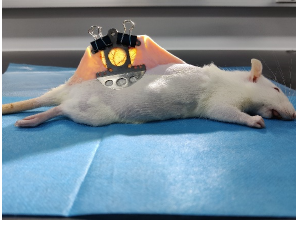
Figure 1. Dorsal skin chamber window.